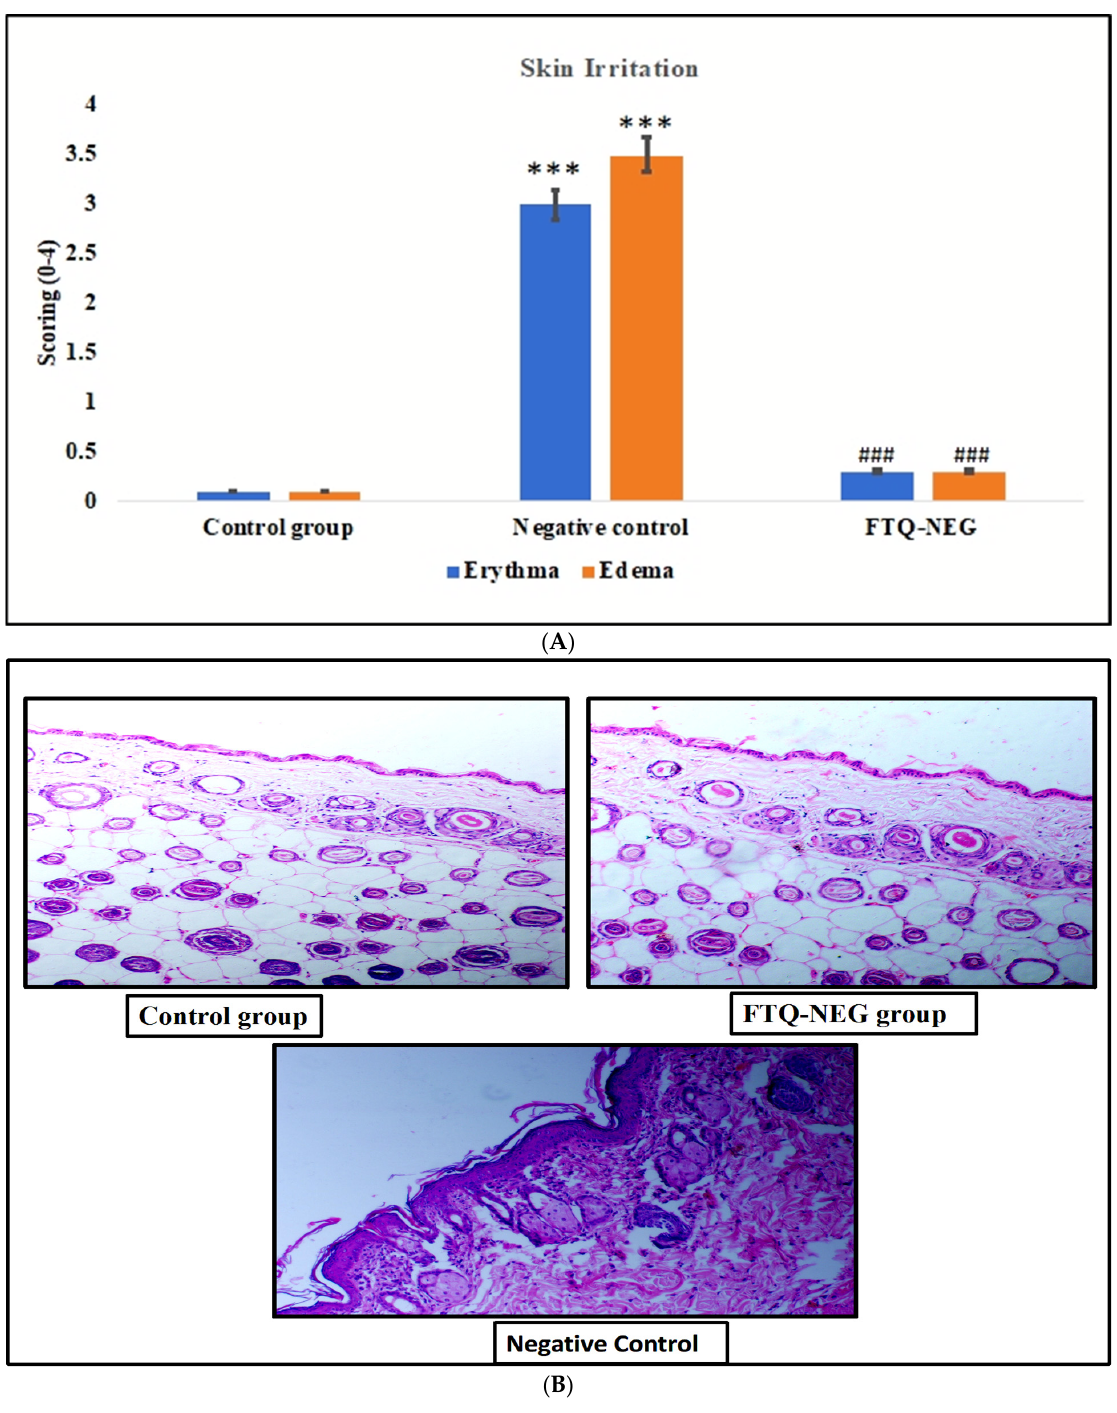
Figure 5. ( A ) The skin irritation potential score of all the groups. Data are expressed as mean ± SD (*** p < 0.001, control group vs negative control for erythema and edema) and ( ### p < 0.001, negative control vs FTQ-NEG for erythema and edema). ( B ) Histopathology of all the treatment groups: Control, FTQ-NEG, and Negative